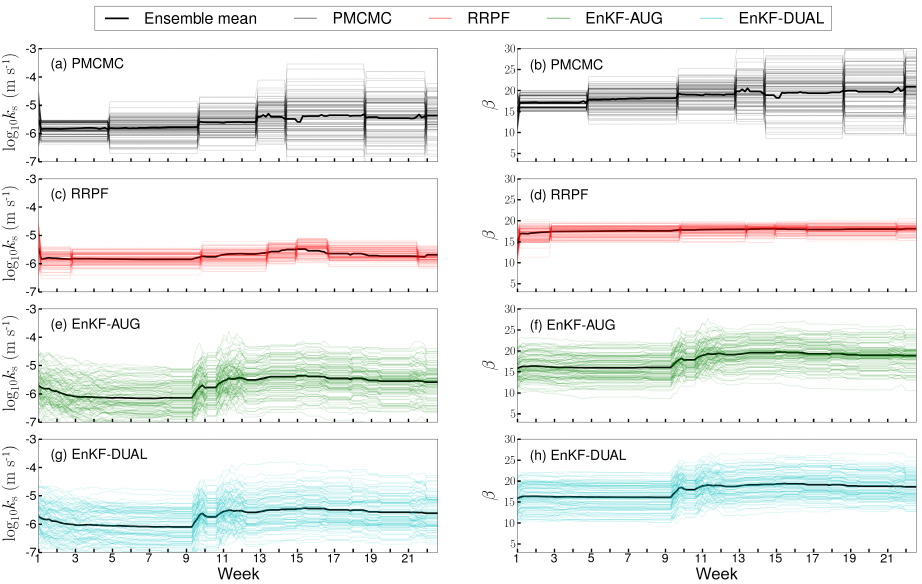
Figure 5. Sampled trajectories of the N = 100 ensemble members of the saturated hydraulic conductivity (log 10 k s in ms − 1 ) at 20cm depth (a, c, e, g) and parameter β (b, d, f, h) of VIC-3L during the 5-month assimilation period of weeks 1 to 22 using (a–b) PMCMC (grey) (c–d) RRPF (red), (e–f) EnKF-AUG (green), and (g–h) EnKF-DUAL (cyan). The trajectory of the ensemble mean is separately indicated in each panel using the solid black